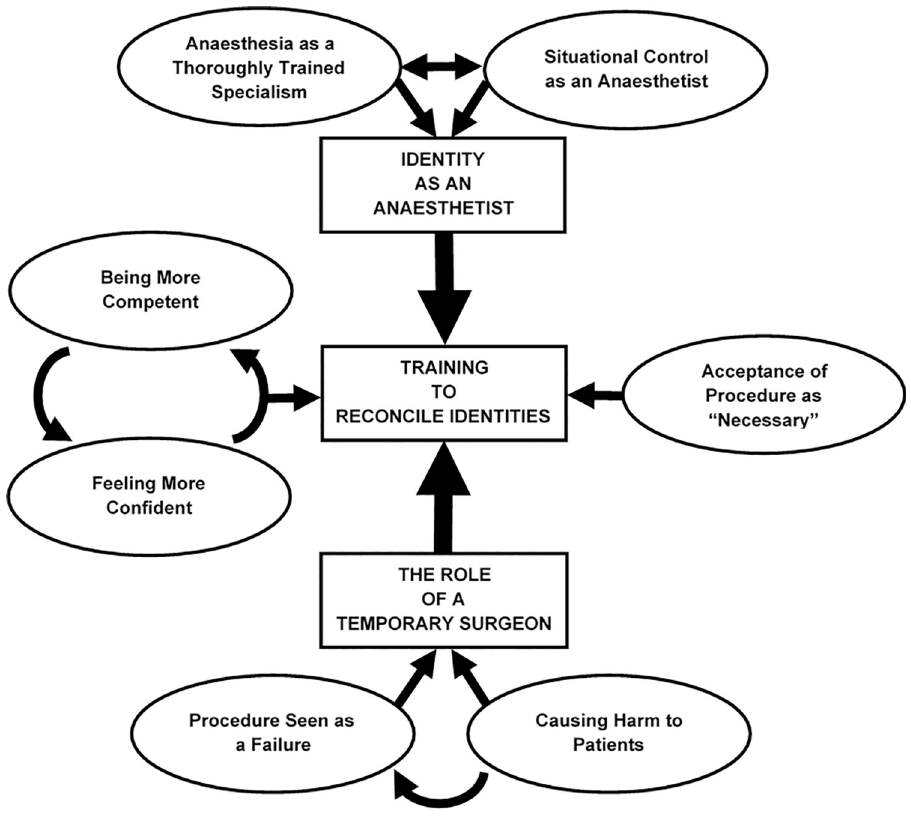
Fig 2. Thematic diagram of